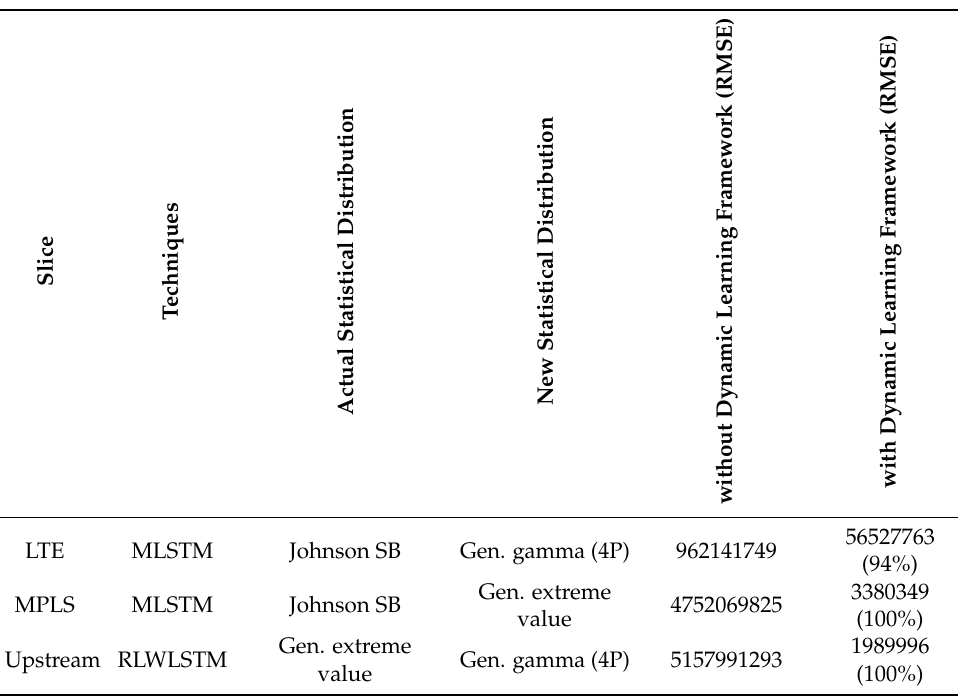
Table 8. Performance of dynamic